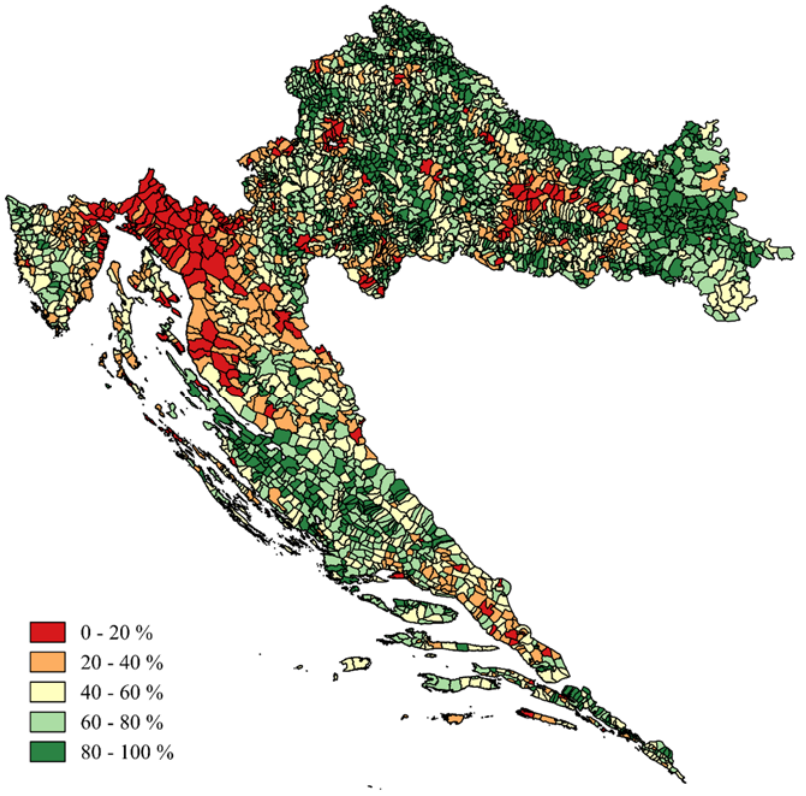
Figure 3. Share of total agricultural land by cadastral municipalities, according to CLC 2012.